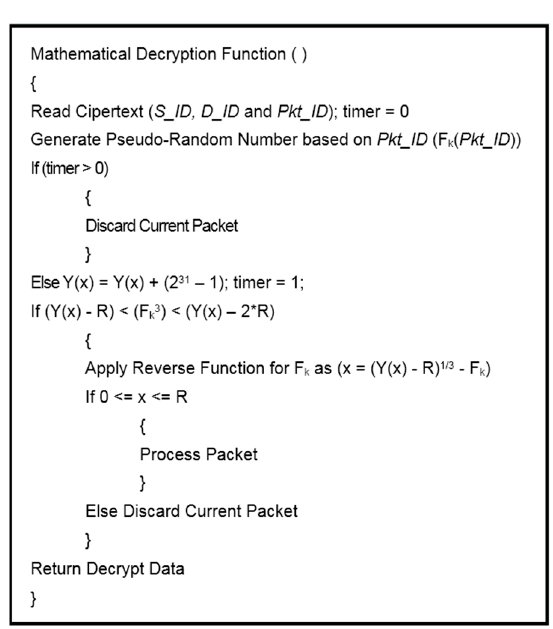
Figure 4. Decryption with authentication.